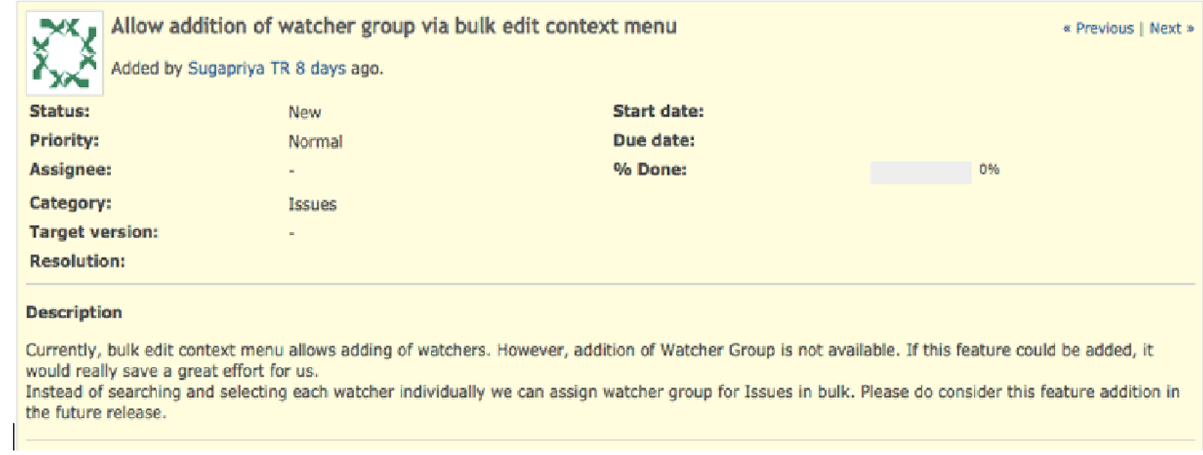
Fig 4. Redmine project task without customized field.